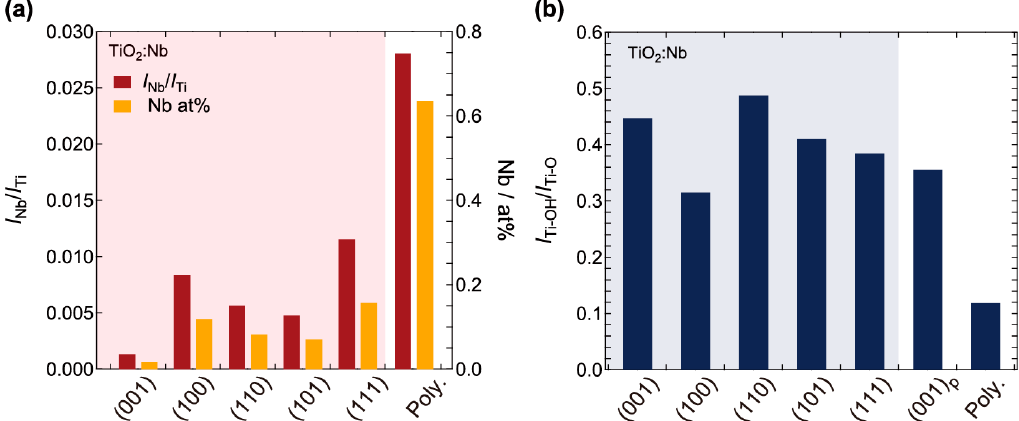
Figure 4. ( a ) Relative peak intensity ratio in the XPS spectra for Nb 3 d 3/2 and Ti 2 p 1/2 and the calculated Nb content (at%). ( b ) Relative peak intensity ratio in the XPS spectra for Ti–OH and Ti–O at the O 1 s in the TiO 2 :Nb (TiO 2 ) single-crystal substrates and TiO 2 :Nb 2 O 5 polycrystalline